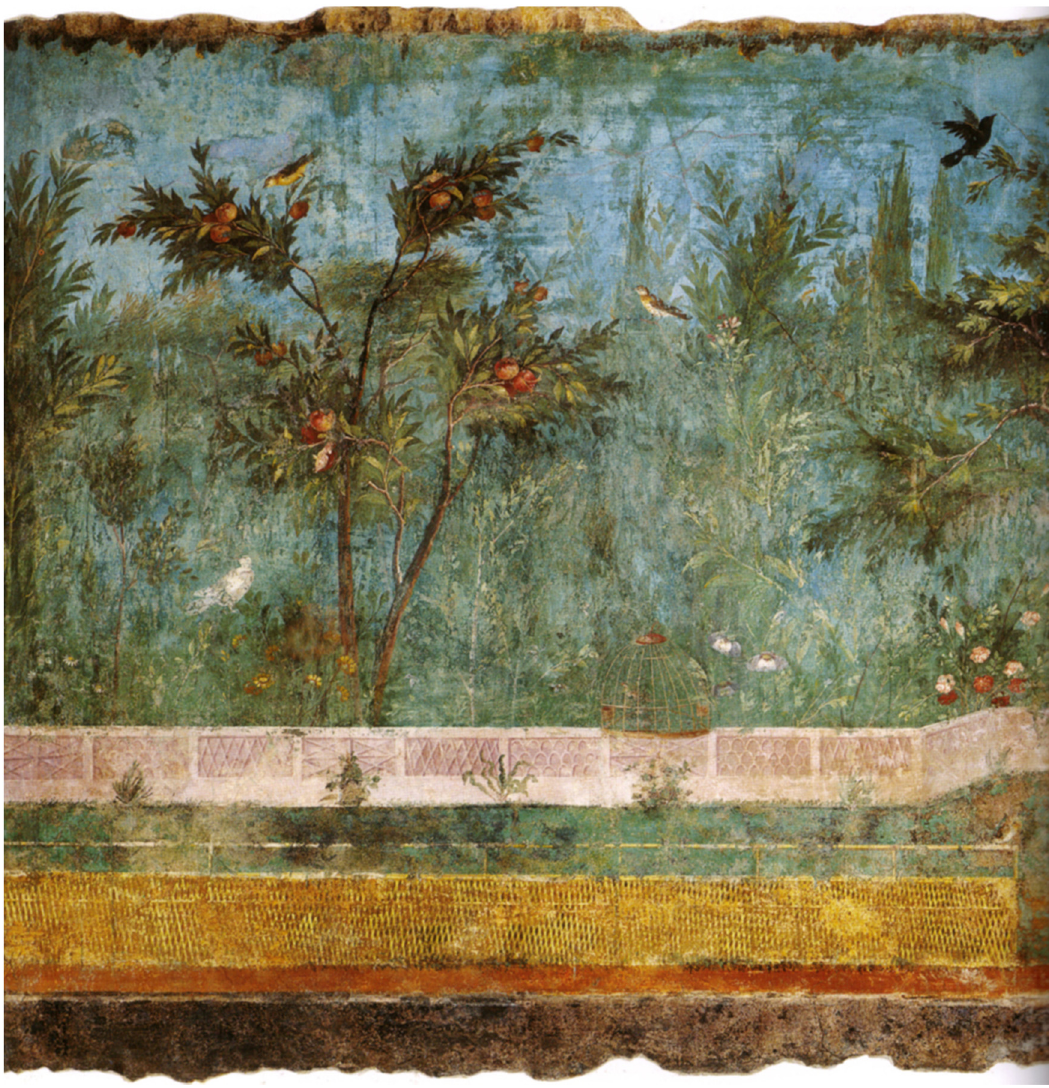
Figure 1: Garden fresco. Roman wall - painting in the Villa of Livia at Prima Porta ( 30 – 20 BC ) . Source: Wikimedia